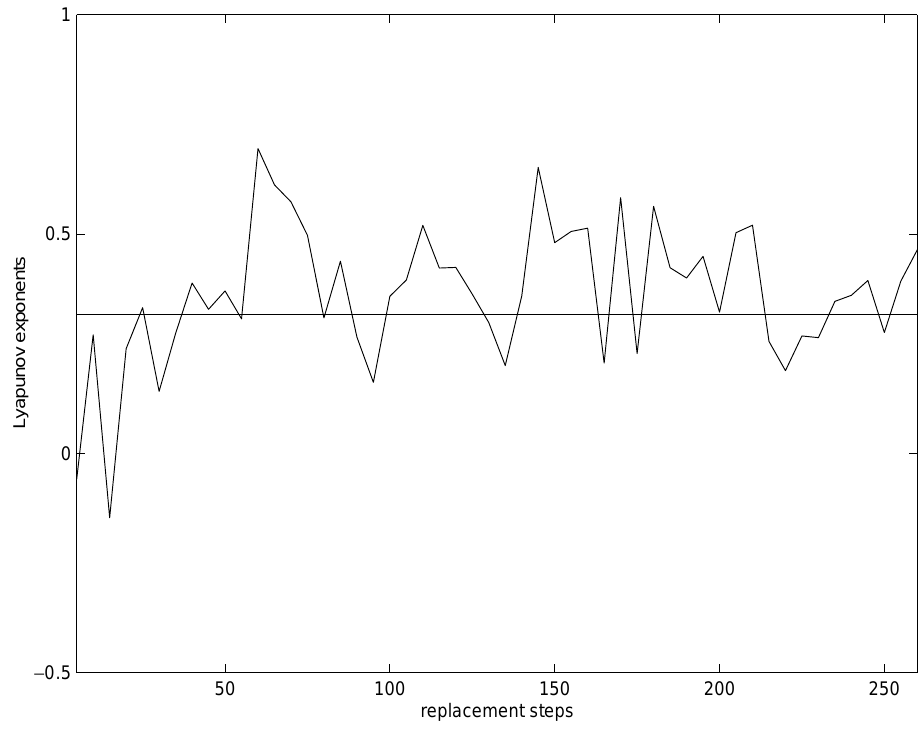
Fig. 15. Evolution of the Lyapunov exponent with respect to replacement steps with low pass filtering. observed when reduced frequency varies for the same freestream velocity. It is possible to infer that bifurcation and chaotic behaviour are related to the aeroelastic system. It has been observed that when the turntable is left free in the aerodynamic flow, a self-sustained oscillation appears. In this case, the existence of the bouncing phenomenon, characterizing a resonance mode, is observed. The reconstructed attractors depict a closed orbits corresponding to irregular